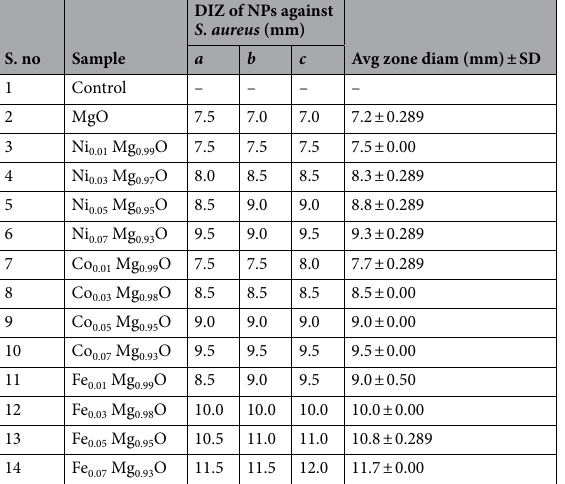
Table 7. The average diameter of inhibition zone of Ni, Co, and Fe-MgO nanoparticles at 80 μg/ml against S. aureus